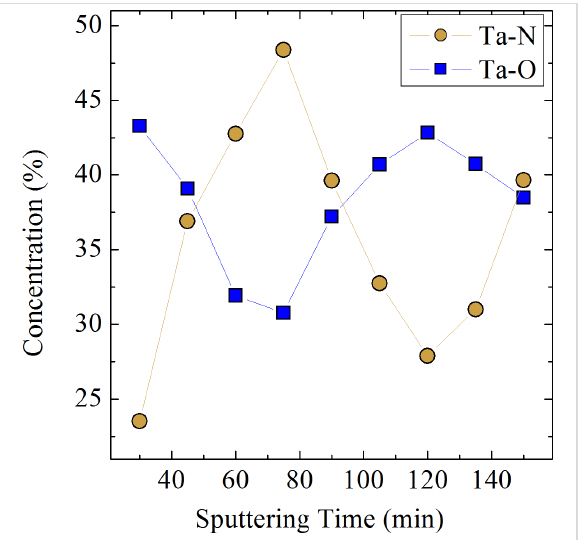
and 30%, respectively, while the corresponding fractions for the Ta–O bonds are 41% and 44%,